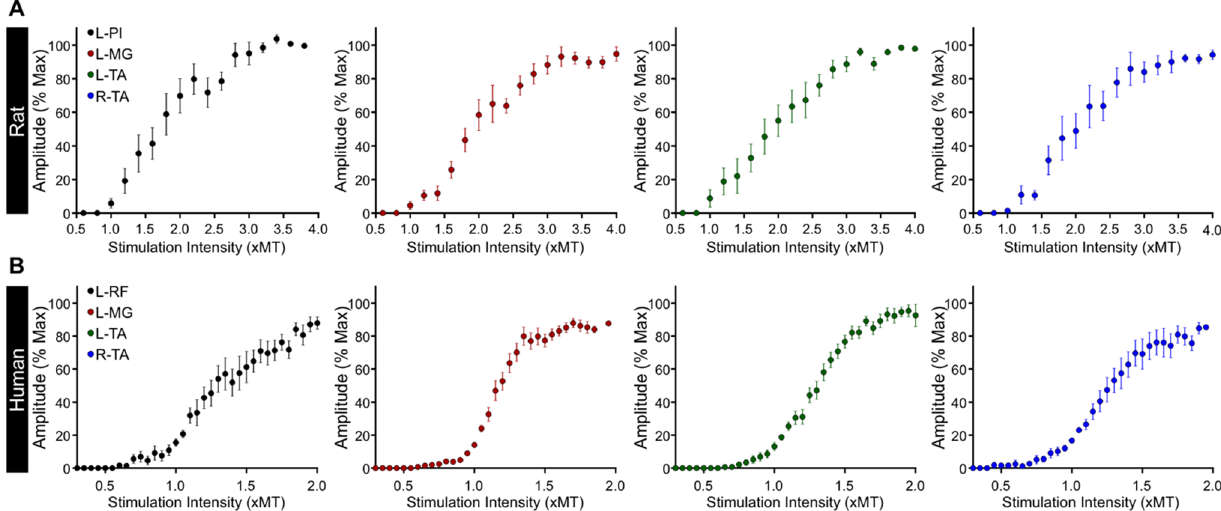
Figure 5. Recruitment curves of transspinal evoked potentials (TEPs). Group average of the input– output relationship in rat ( A ) and human ( B ) leg muscles. L, left; R, right; Pl, plantar muscle; MG, medial gastrocnemius; TA, tibialis anterior; RF, rectus femoris. Average ± SEM predicted values from the sigmoid fit with stimulation intensities plotted against TEP amplitude. Max is the maximal amplitude of the TEP; m is the slope parameter of the sigmoid function; S50 is the stimulus intensity required to elicit a TEP equivalent to 50% of the maximal amplitude (mA); slope is the slope of the sigmoid relationship confined to occur at S50; S-thresh- old and S-max are predicted stimulation intensities (mA) corresponding to threshold and maximal